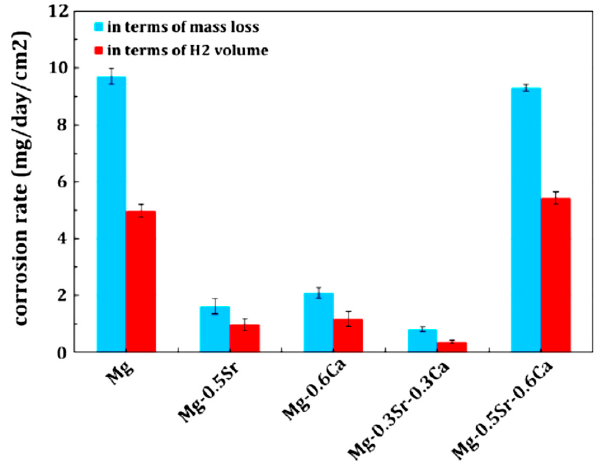
Figure 29. Corrosion rate of pure Mg, binary and ternary alloys in SBF at 37 °C. Reproduced with permission from [156], Elsevier, 2014.